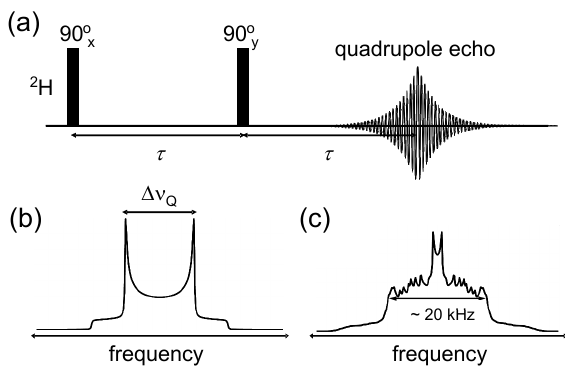
Figure 9. 2 H NMR determination of C–H bond dynamic order parameters. ( a ) Pulse sequence of the quadrupolar-echo experiment; ( b , c ) Illustrative simulated spectra of the quadrupole echo from a sample of multilamellar vesicles in the L α phase with selectively single-site deuterated phospholipids ( b ) and per-deuterated phospholipids ( c